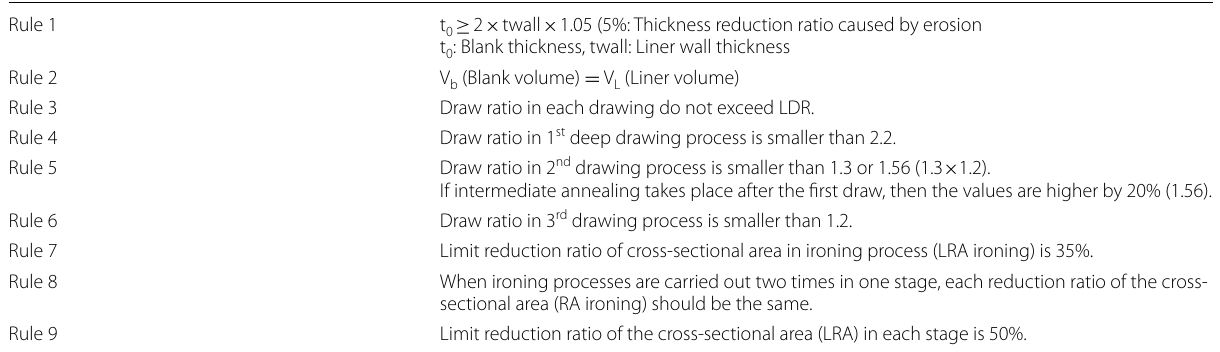
Table 1 Design rules of DDI process [23,